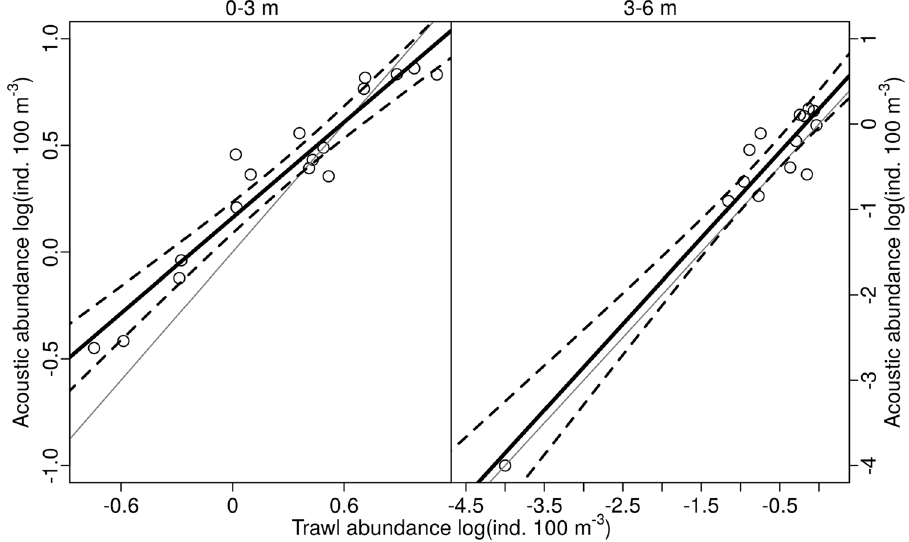
Figure 4. Linear regression model between upward-looking hydroacoustic abundance and trawl abundance (38 kHz). Each dot represents a separate sampling event. The regression line is displayed in solid black and the 95% confidence intervals are displayed in dotted lines. The 1:1 line is displayed in solid grey. The regression equation for each depth layer (y = 0.092 + 0.691x; r 2 = 0.75 and y = 0.15 + 1.029x; r 2 = 0.92, respectively for the 0–3 m and 3–6 m depth